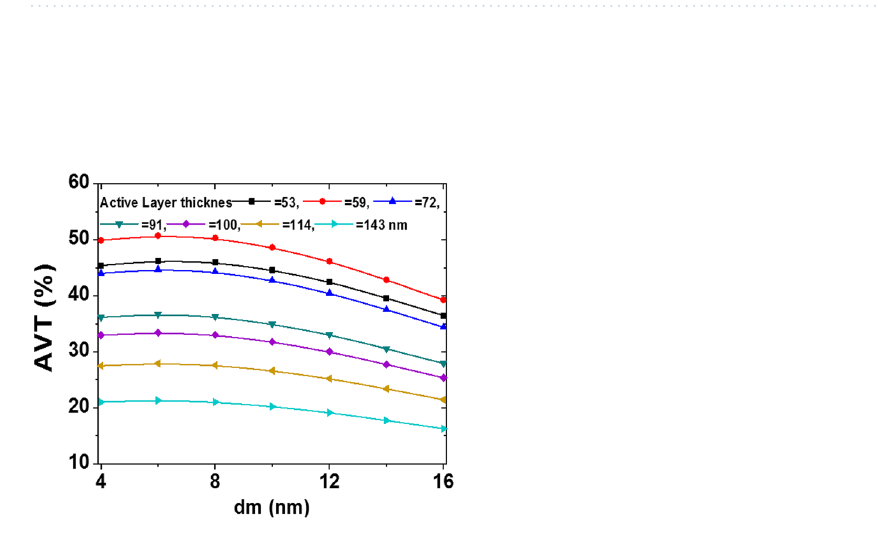
Figure 8. The AVT (%) of the devices as a function of active and ‘d m ’ layers